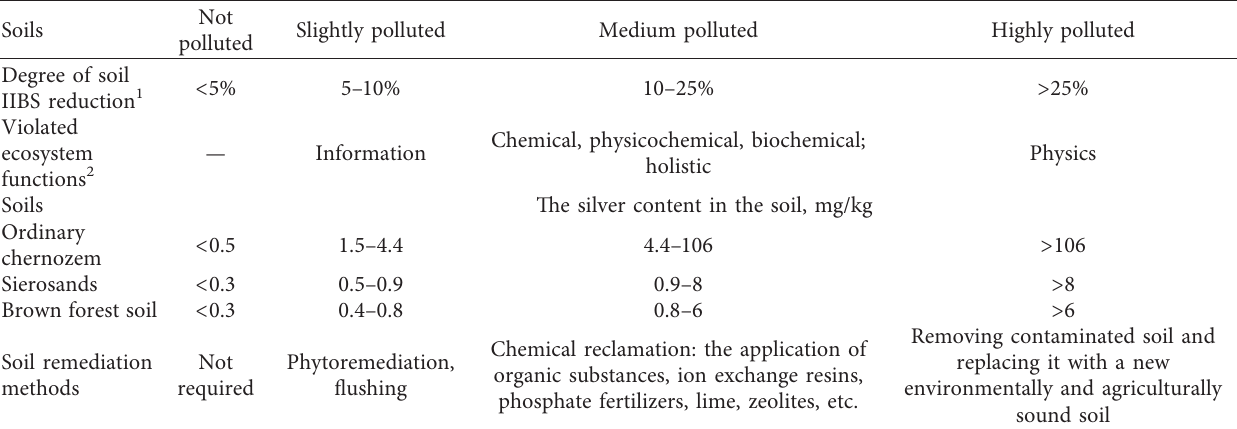
Table 3: The scheme of environmental regulation of silver pollution of soils of Southern Russia by the degree of violation of ecosystem (biogeocenotic)